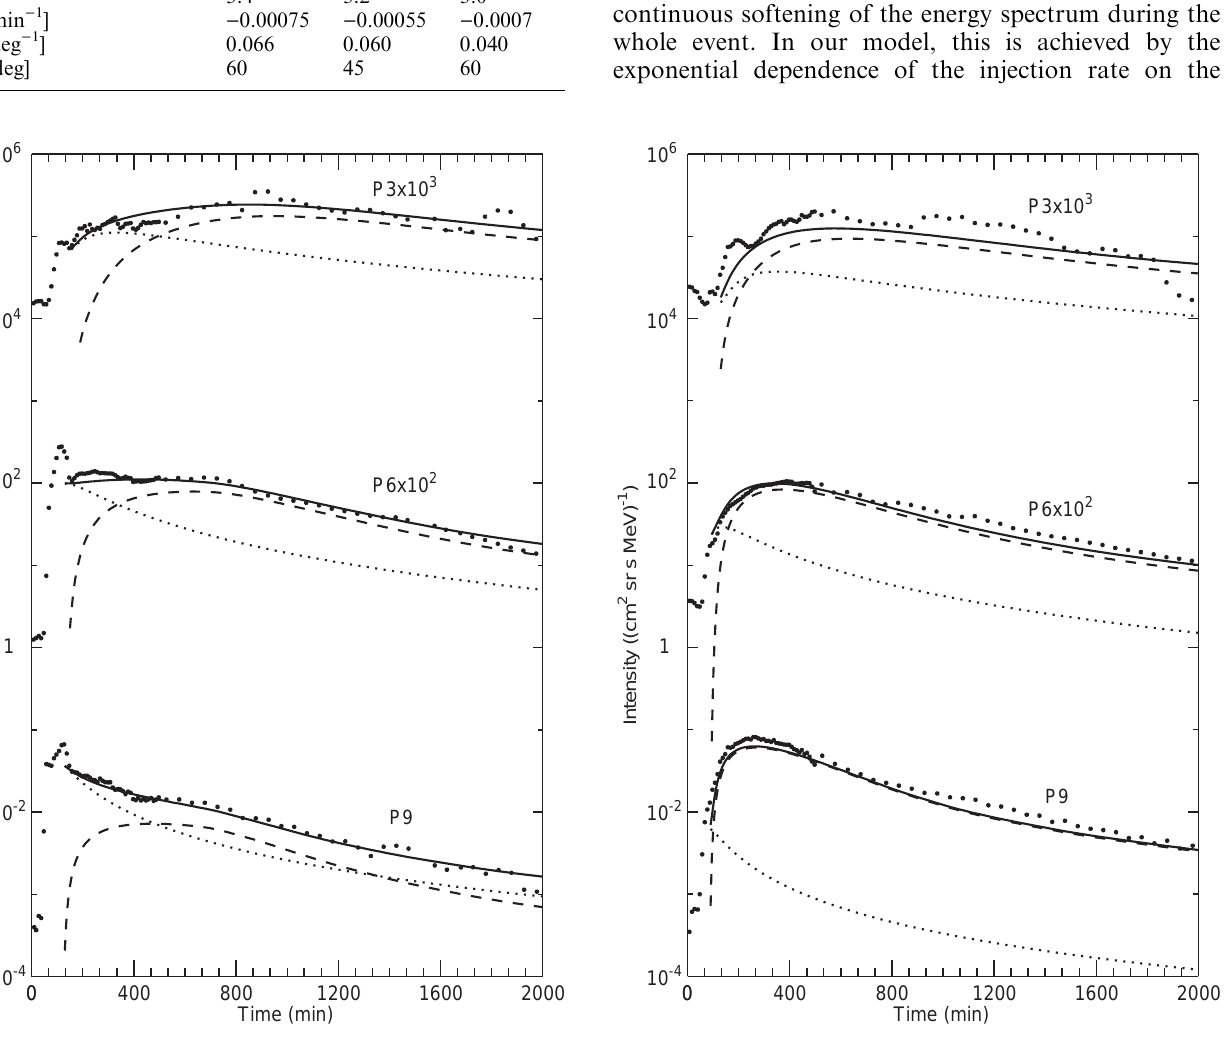
Fig. 3. Observed (GOES-6) and calculated pre-shock count rates of the 22 October 1989 SEP event in proton channels P3, P6 and P9. The symbols are the same as in Fig. 2